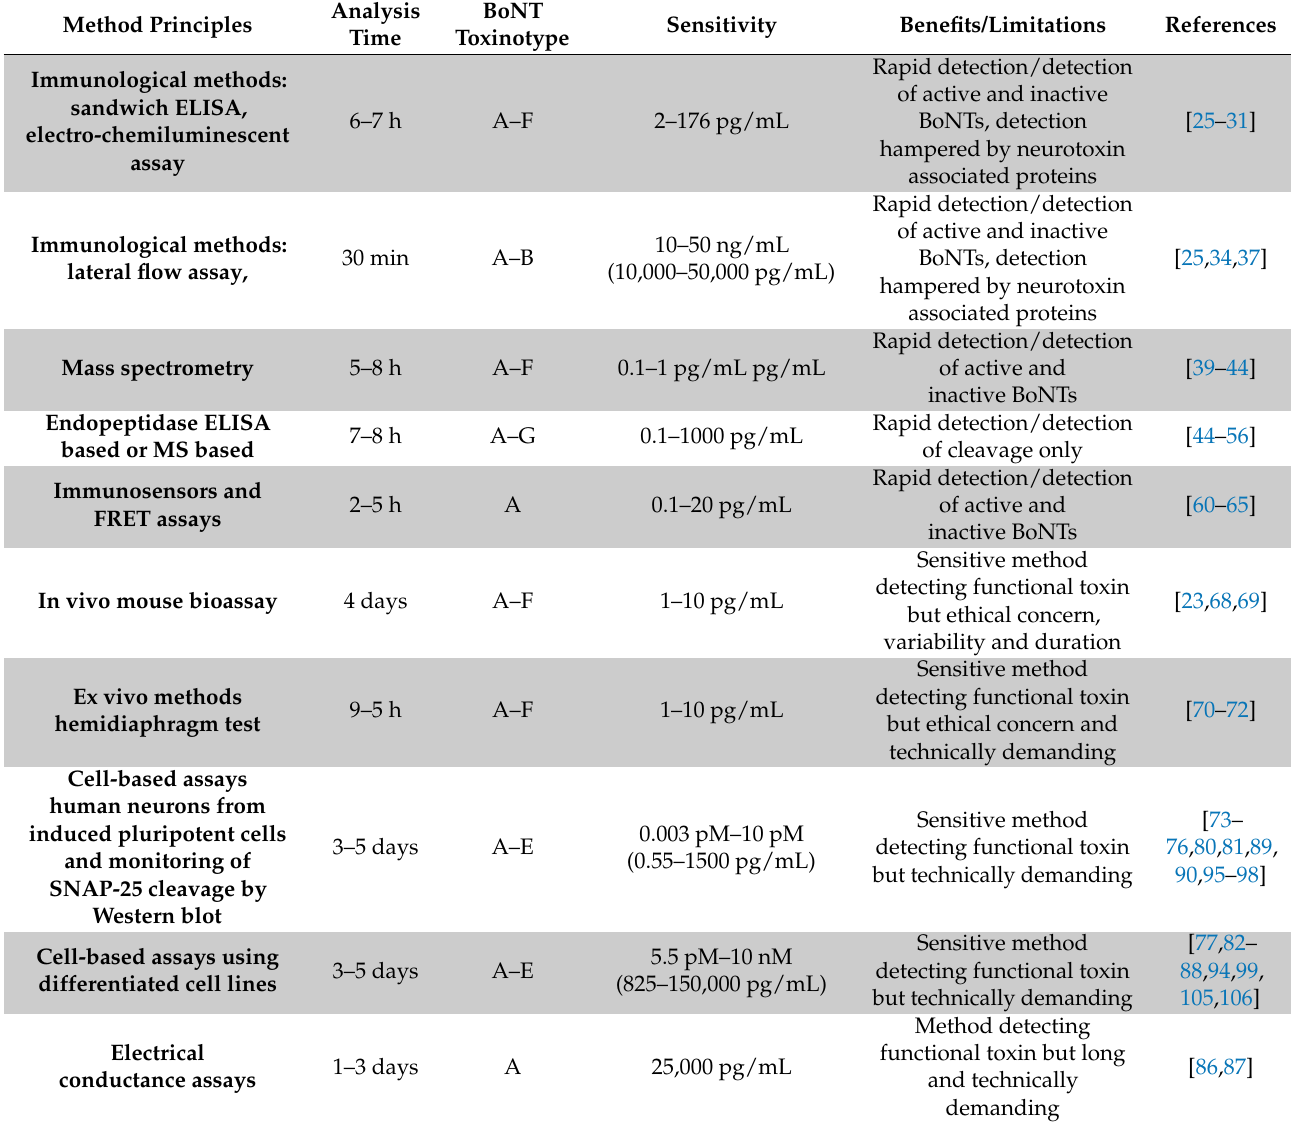
Table 2. Methods of BoNT detection, sensitivities and